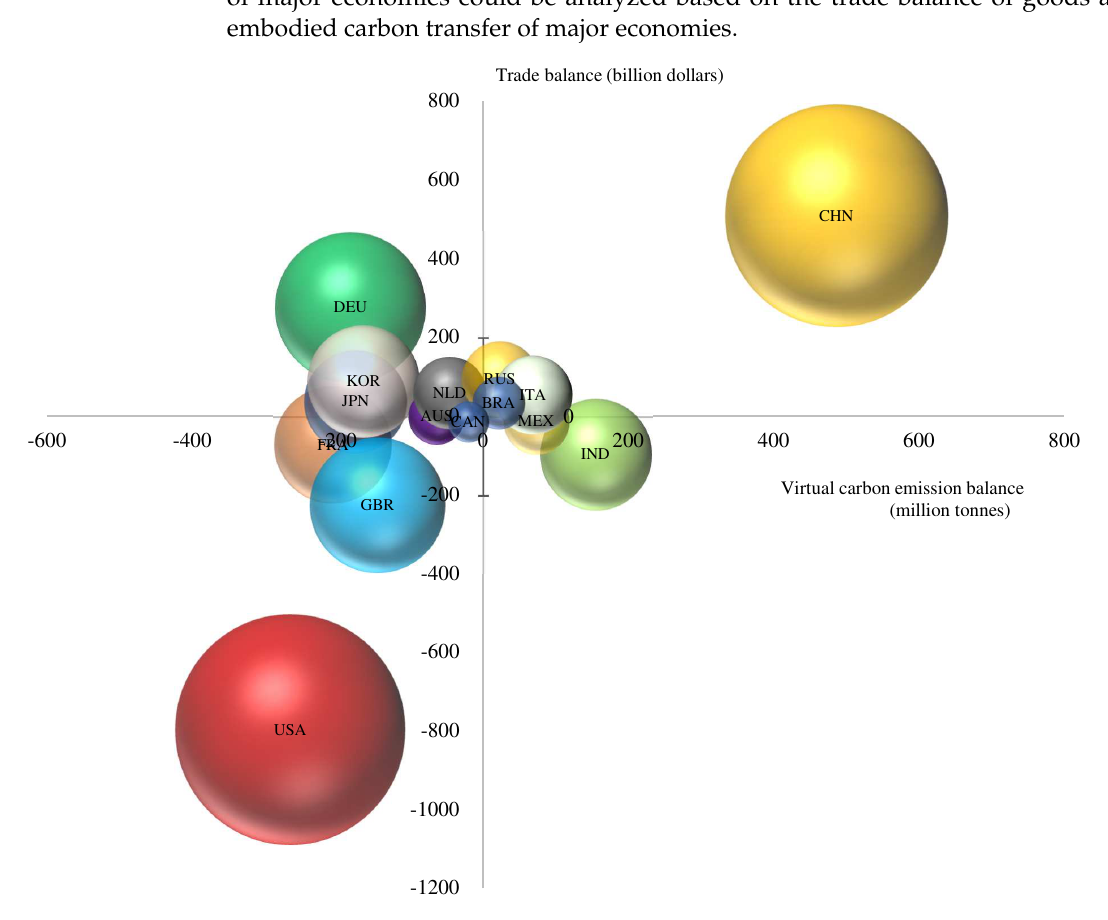
Figure 4. Trade and carbon trade balances for major economies.